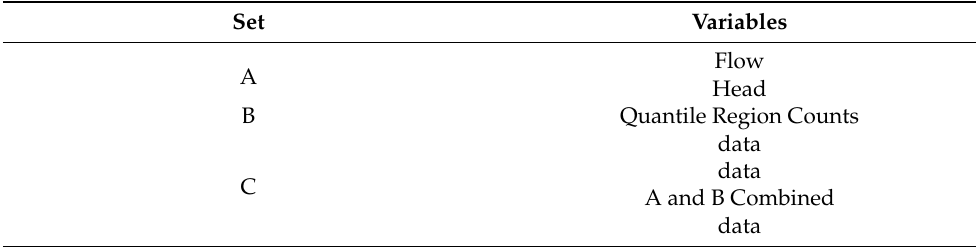
Figure 2. Secondary loop with placement of turbine-driven boiler feed pump shown. Table 1. Candidate Covariate Sets.